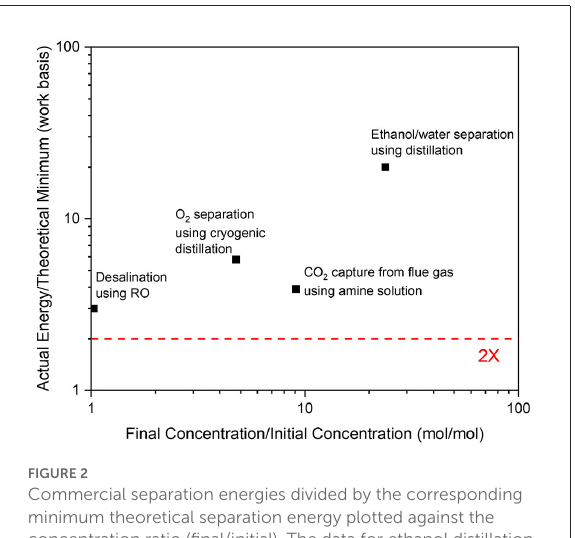
FIGURE2 Commercial separation energies divided by the corresponding minimum theoretical separation energy plotted against the concentration ratio (final/initial). The data for ethanol distillation (Leeper, 1992), desalination (Abou Rayan and Khaled, 2003), O 2 separation (Singh et al., 2003), and CO 2 capture from flue